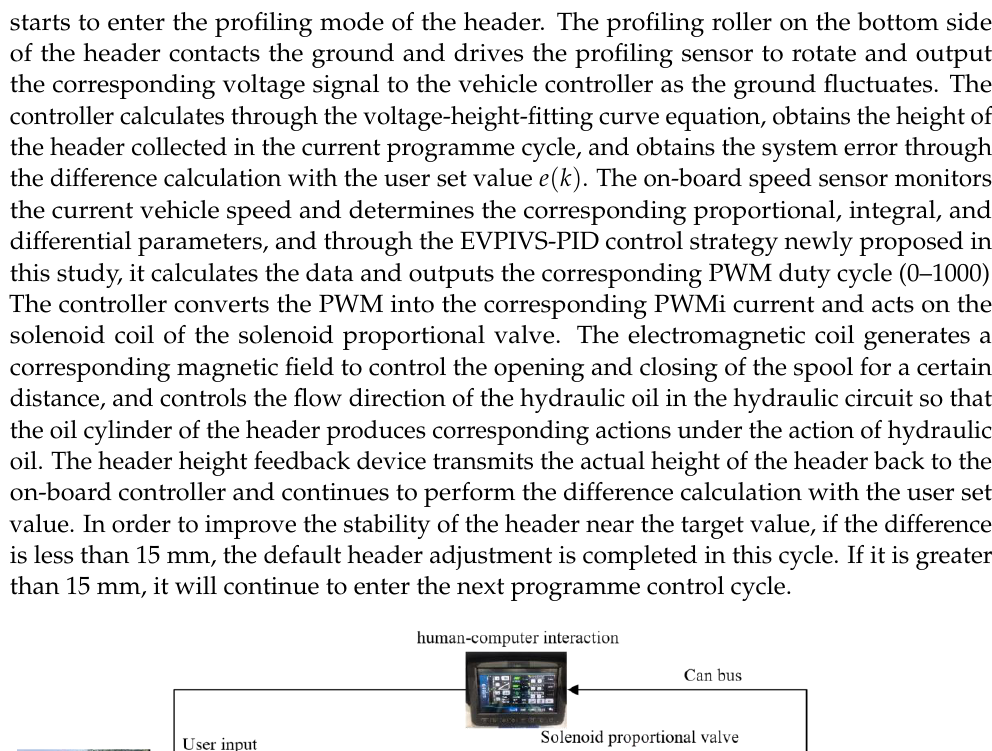
4 of 25 Figure 3. Header height feedback sensing mechanism. 1. Angle sensor; 2. Articulated link.